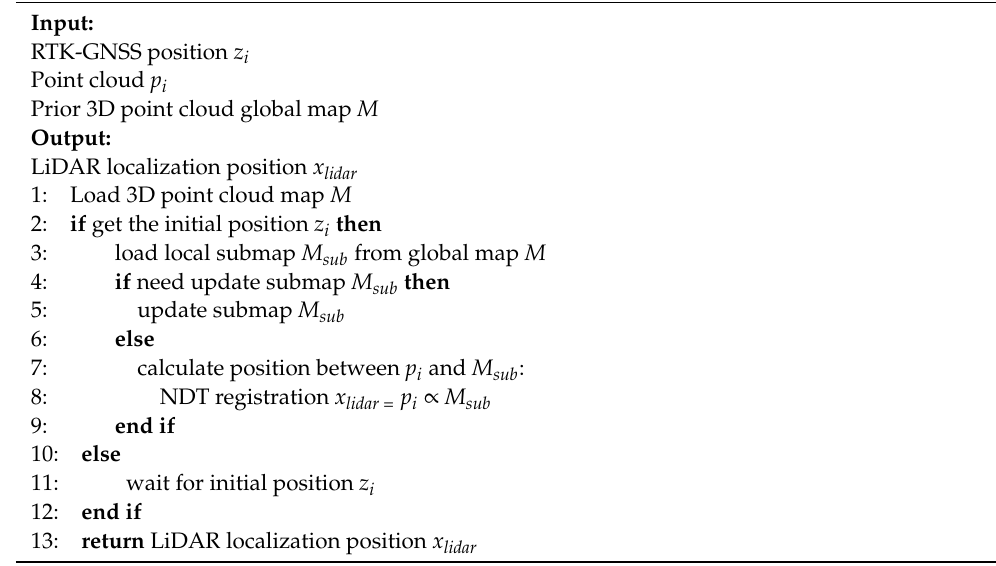
Algorithm 2. LiDAR localization in prior 3D point cloud